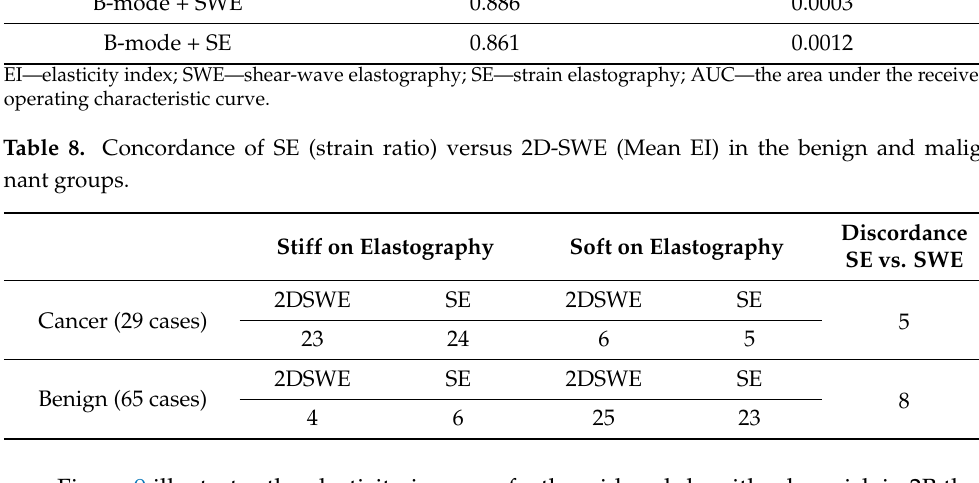
Table 7. The performance of strain and 2D shear-wave parameters alone and as additional evaluation for conventional ultrasound (2B), being compared to 2B evaluation alone.